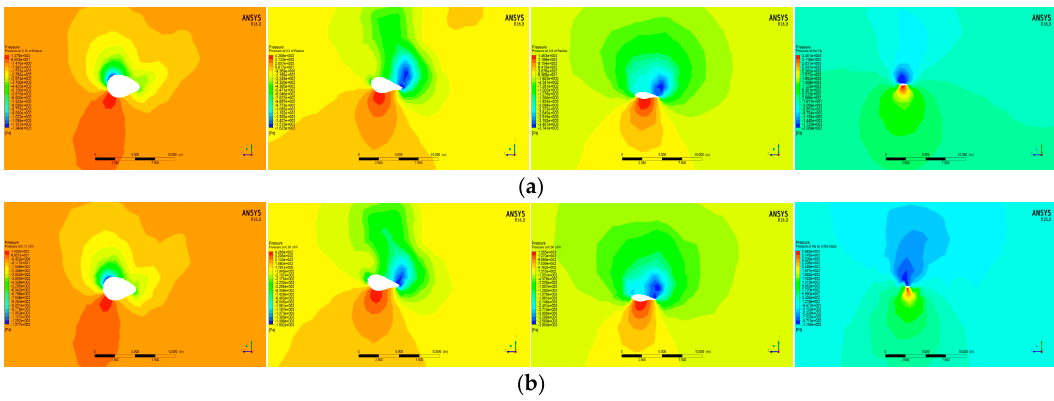
Figure 13. Pressure contour, ( a ) uni-directional; and ( b ) bi-directional coupling at the end of 5 s.